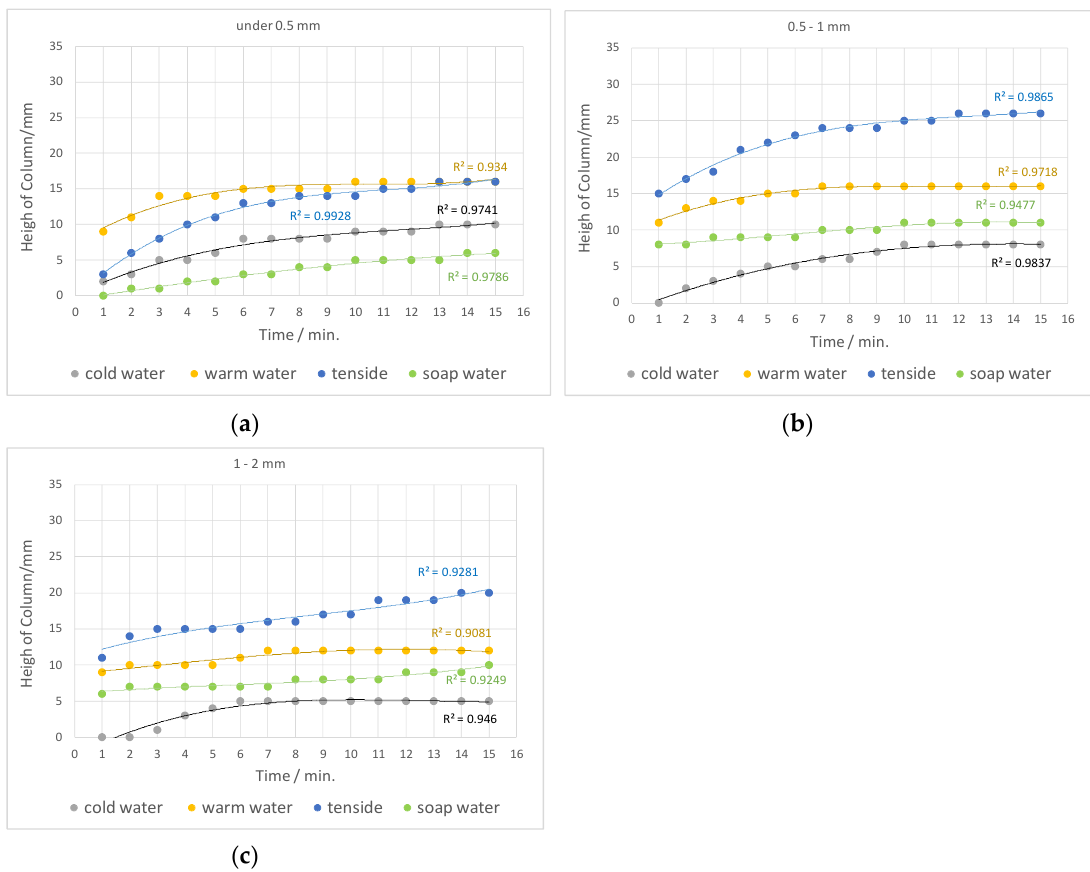
Figure 9. Wetting of oak sawdust at granulometric compositions: ( a ) Under 0.5 mm; ( b ) 0.5–1 mm; ( c ) 1–2 mm.